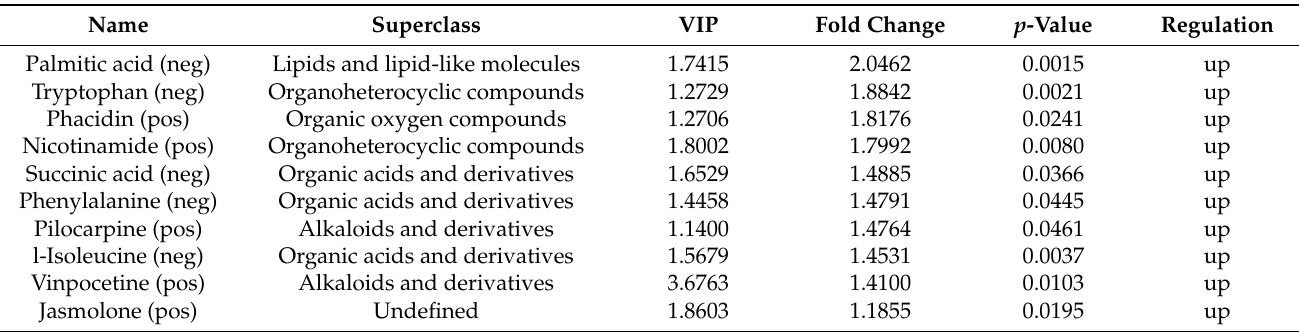
Table 1. Differential metabolites significantly upregulated in jasmonic acid-induced kidney bean leaves, compared with the control.